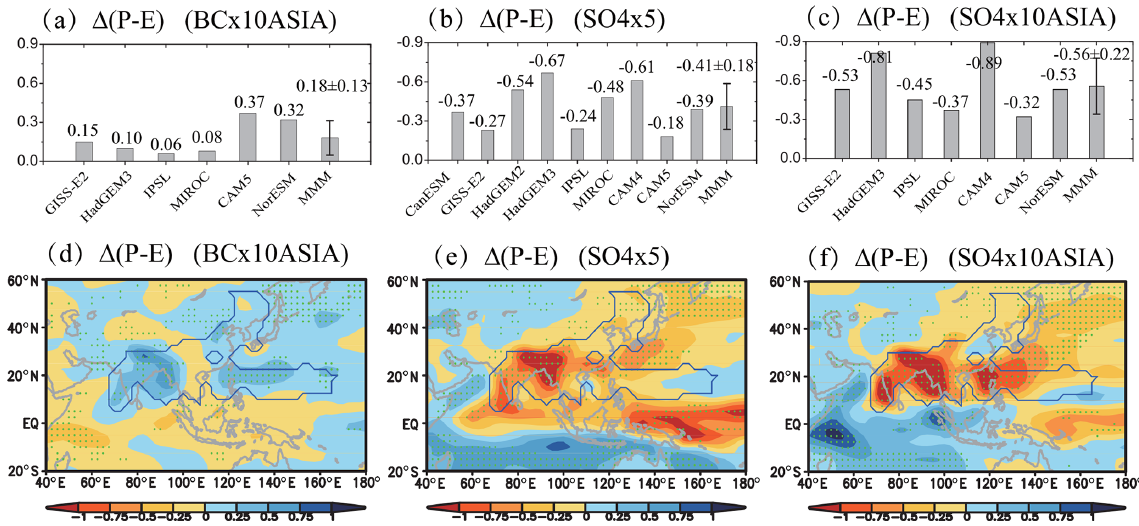
Figure 12. Changes in the MJJAS precipitation minus evaporation ( (cid:49) ( P − E ); unit: mmd − 1 ) under (a, d) increasing Asian BC, (b, e) global SO 4 and (c, f) Asian SO 4 . (a, b, c) Domain-averaged value over the Asian monsoon region and (d, e, f) spatial pattern of the multimodel mean (MMM). Error bars (a, b, c) of the MMM represent the standard deviation. Dotted regions (d, e, f) indicate where the MMM is more than 1 standard deviation away from 0. The areas within the blue line represent the Asian monsoon region.